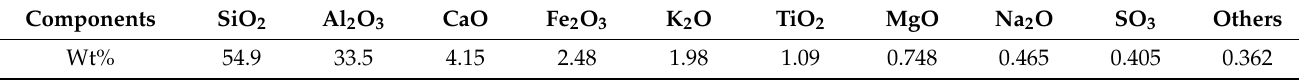
Table 1. Chemical composition of coal fly ash.